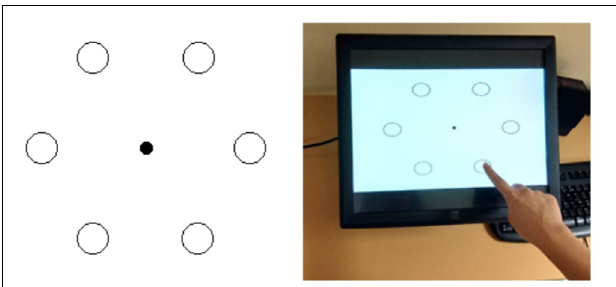
FIGURE 1 | Experimental protocol. (Left) The left panel illustrates a top view of the tactile screen on which the picture of the targets was displayed throughout each trial. The visual targets consisted in six equidistant circles (diameter: 1.2 ◦ ) arranged in the form of a hexagon. (Right) The right panel is a picture of a participant who was asked to point clockwise each circle, one after the other, in synchrony with a series of beeps ( N = 30 or 34 depending on auditory sequences). These sounds were emitted by a computer and played through table-top speakers.